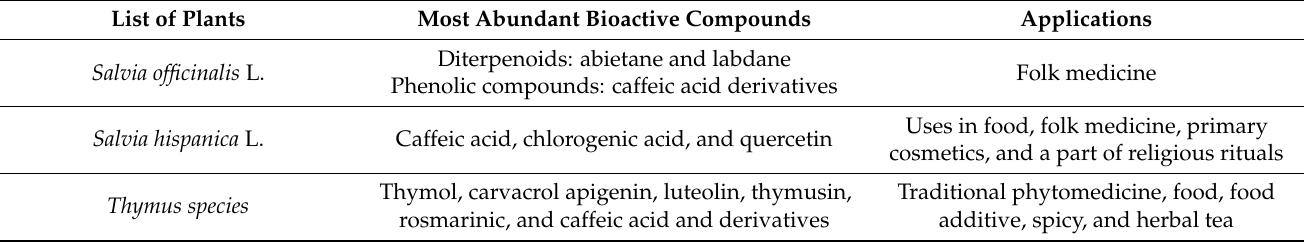
Table 1. An overview summary on the most abundant bioactive compounds in each species, its applications, and the number of citations for